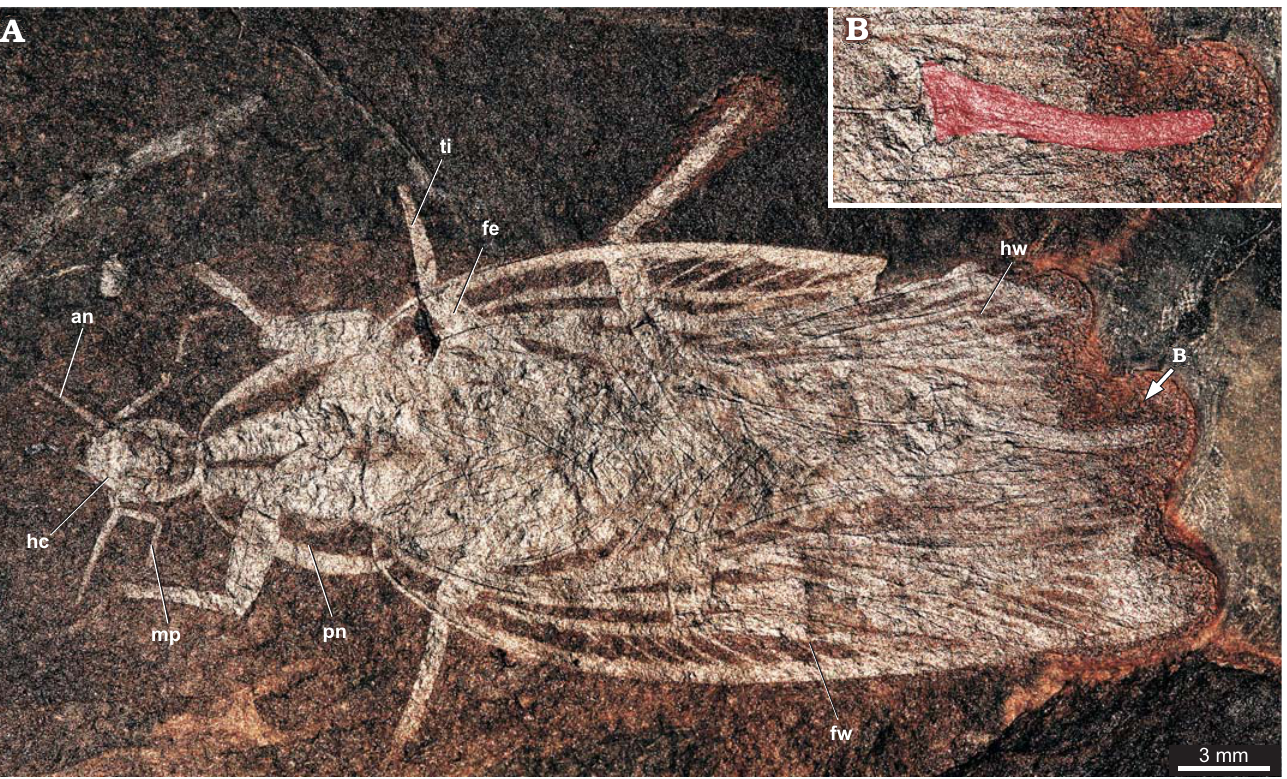
Fig. 14. Roachoid Sysciophlebia balteata (Scudder, 1879) (NHMS-WP 5045) from the early Permian Goldlauter Formation, Thuringian Forest basin, Cabarz quarry, Germany. A . Overview (composite photograph of part and counterpart). B . Close-up of the ovipositor (red-coloured). Abbreviations: an, antenna; fe, femur of prothoracic leg; fw, forewing; hc, head capsule; hw, hind wing; mp, maxillary palpus; pn, pronotum; ti, tibia of prothoracic